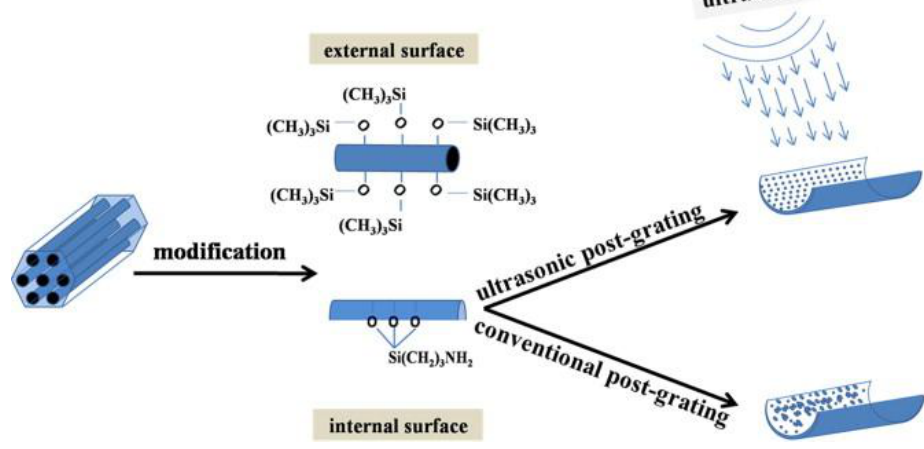
Figure 3. Schematic illustration of the representative synthesis procedure of CuO/SBA-15. Reprinted from Ref. [60], Copyright 2013, with permission from Elsevier.